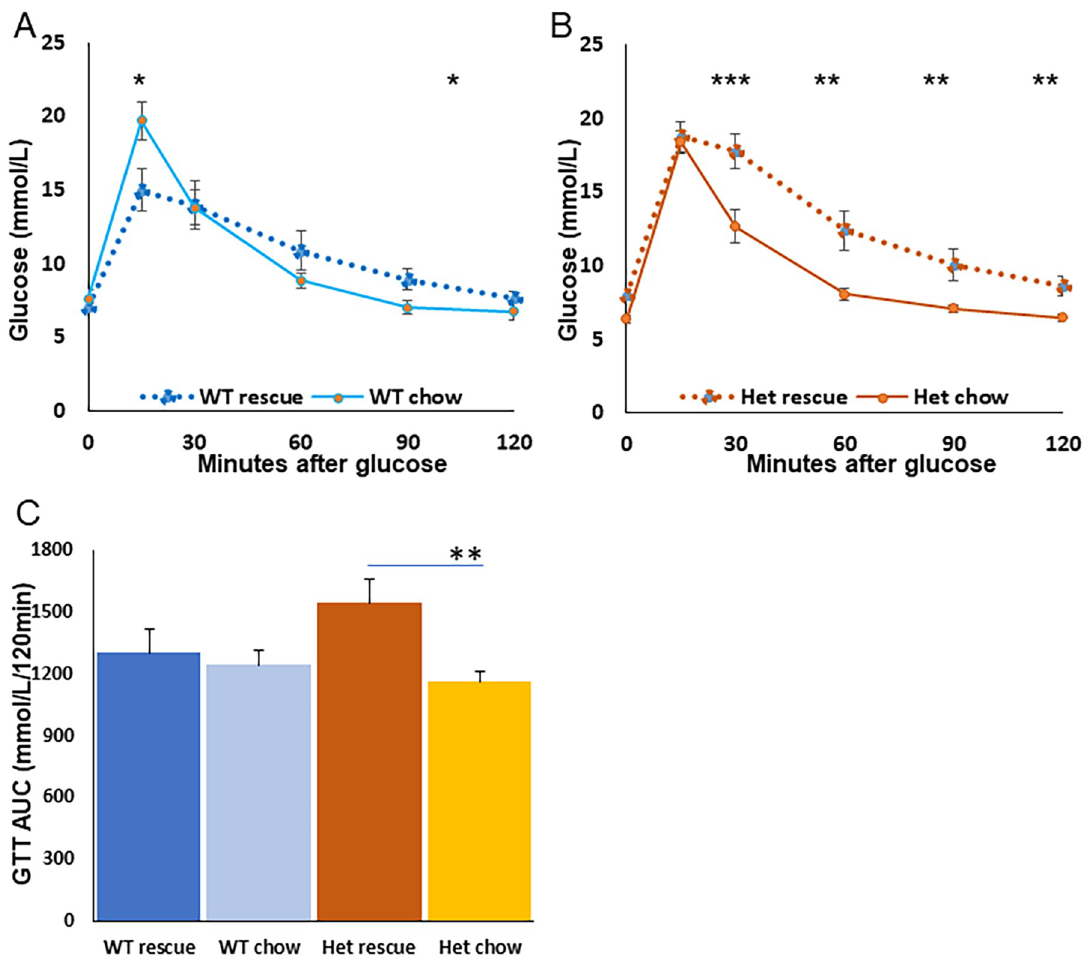
Fig 6. Glucose response to rescue diet compared to chow in WT and Het mice. A) Glucose tolerance test in WT mice. B) GTT in Het mice. C) AUC of GTTs. All mice are female. WT chow N = 4, WT rescue diet N = 8. Het chow N = 8 Het rescue N = 9. � p < 0.05, �� p < 0.01. GTT AUC = glucose tolerance test area under the